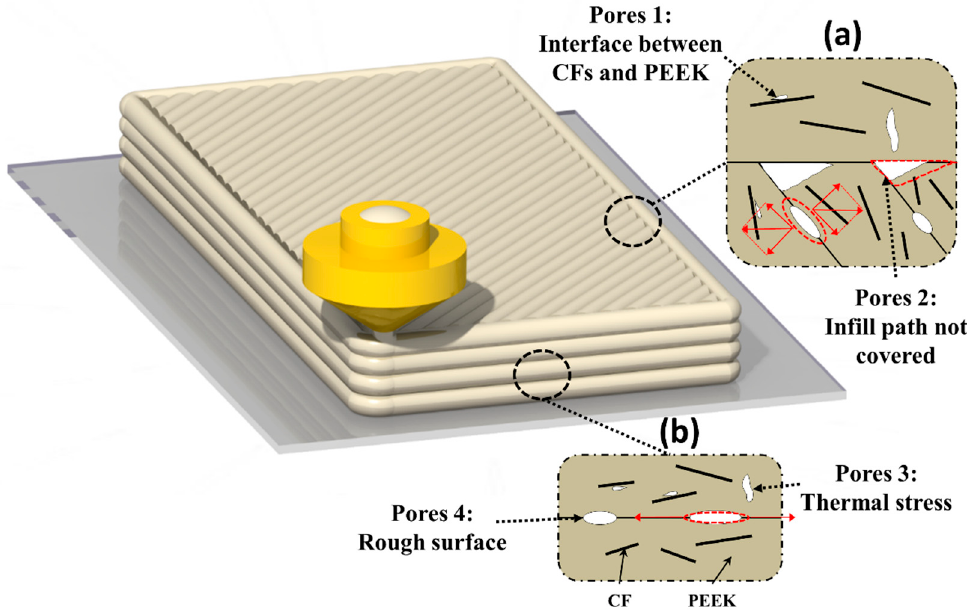
Figure 7. The effect of pores induced by CFs on the flexural behavior of orthogonal printed specimens. The main microstructure of ( a ) horizontal printed parts and ( b ) vertical printed parts that bear the bending stress.